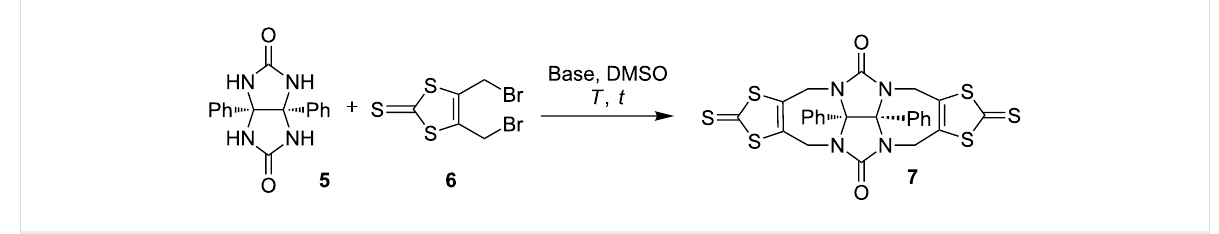
Scheme 2: Reaction between diphenylglycoluril with 4,5-bis(bromomethyl)-2-thioxo-1,3-dithiole.